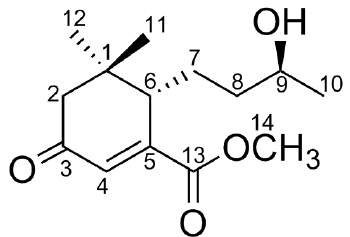
Figure 1. Structure of compound 1 .